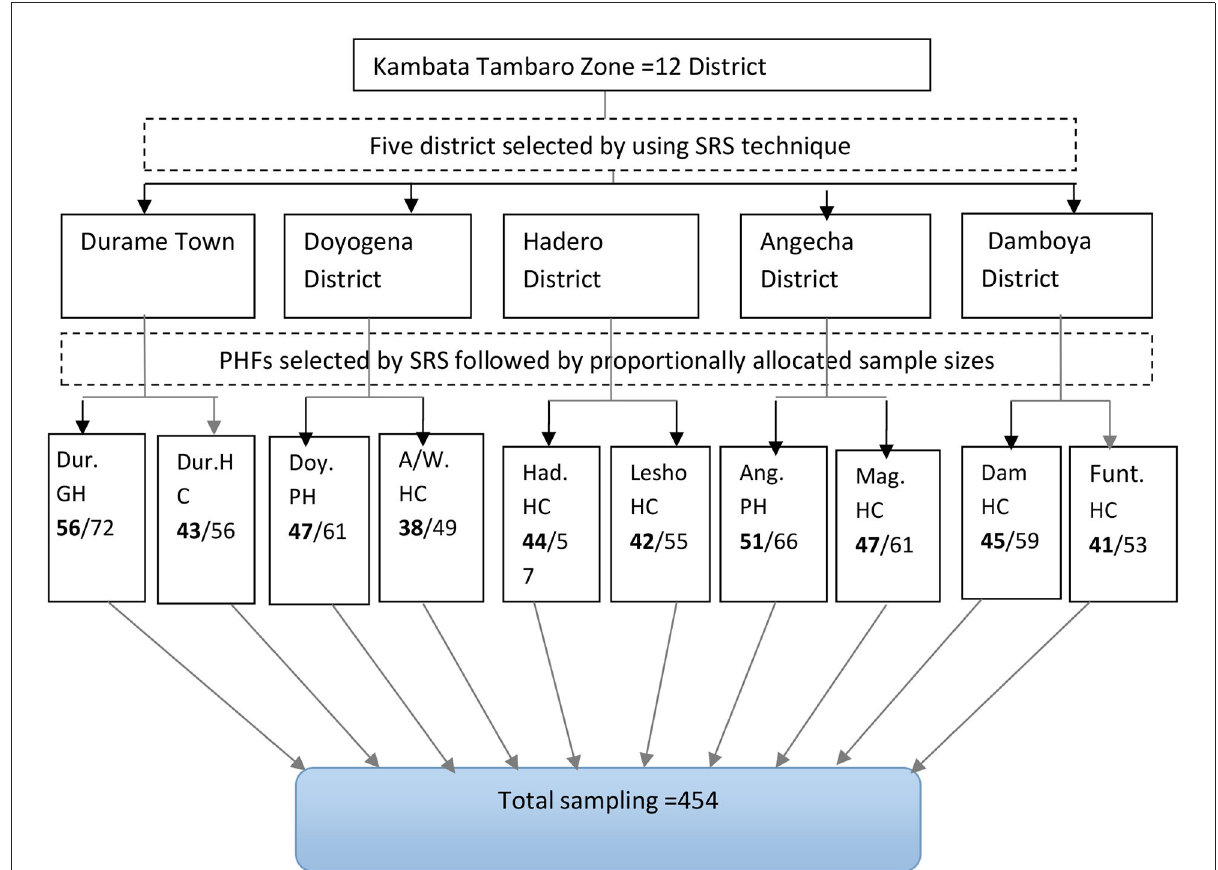
FIGURE1 Schematic presentation of months of sampling procedure among Implanon users visiting public health facilities to discontinue Implanon in the Kambata Tambaro zone, 2020. GH, General hospital; HC, Health center; PH, Primary hospital; PHF, Public health facilities; SRS, Simple random